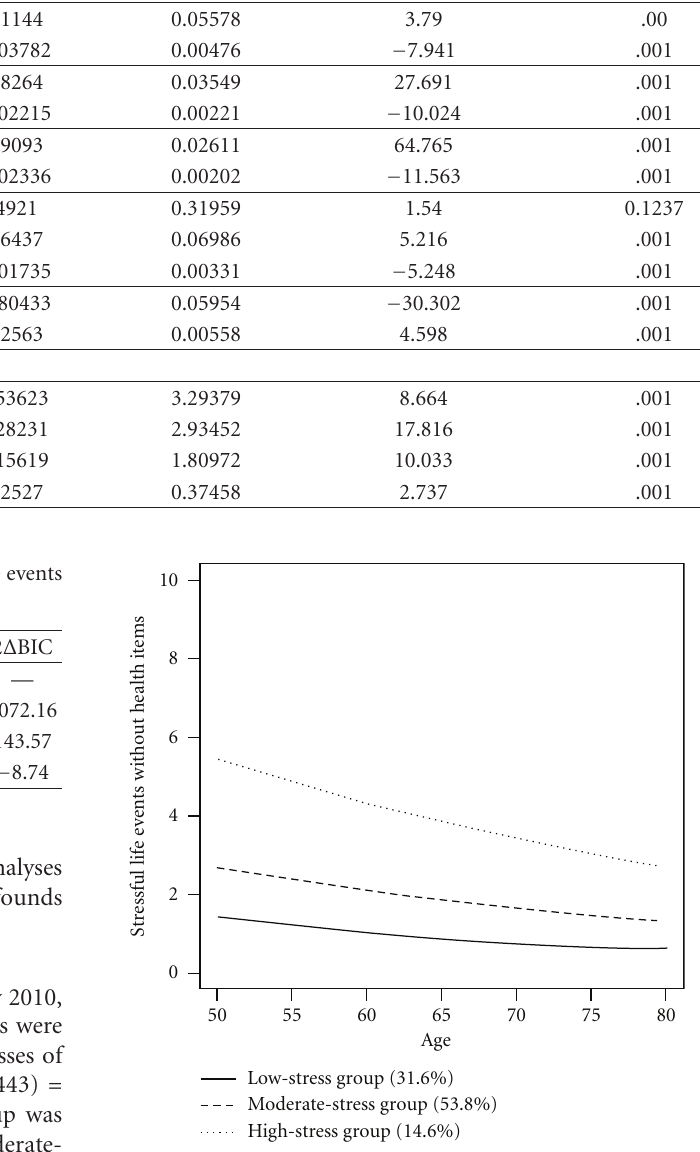
Figure 3: Graphs of the predicted trajectories for the di ff erent life event classes (excluding health